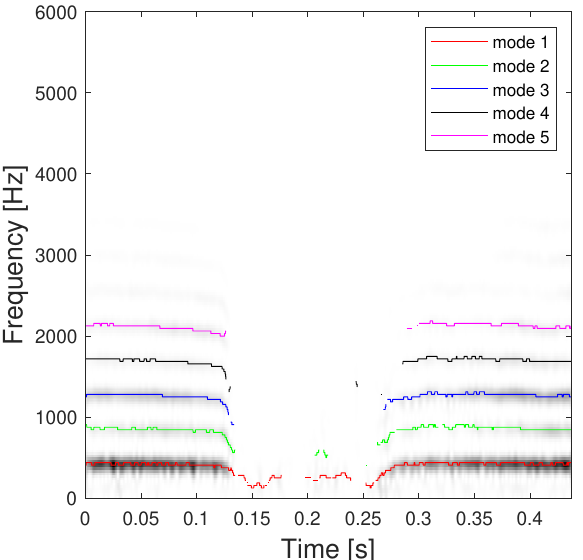
Figure 11. Estimation of the first K = 5 signal components of the piping data using the proposed ABD